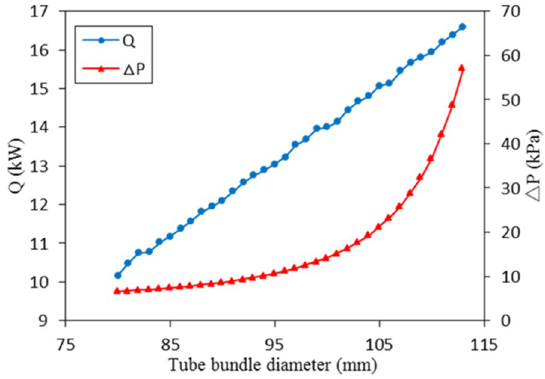
Figure 11. Heat transfer capacity and shell-side pressure drop separately versus tube bundle diameter.